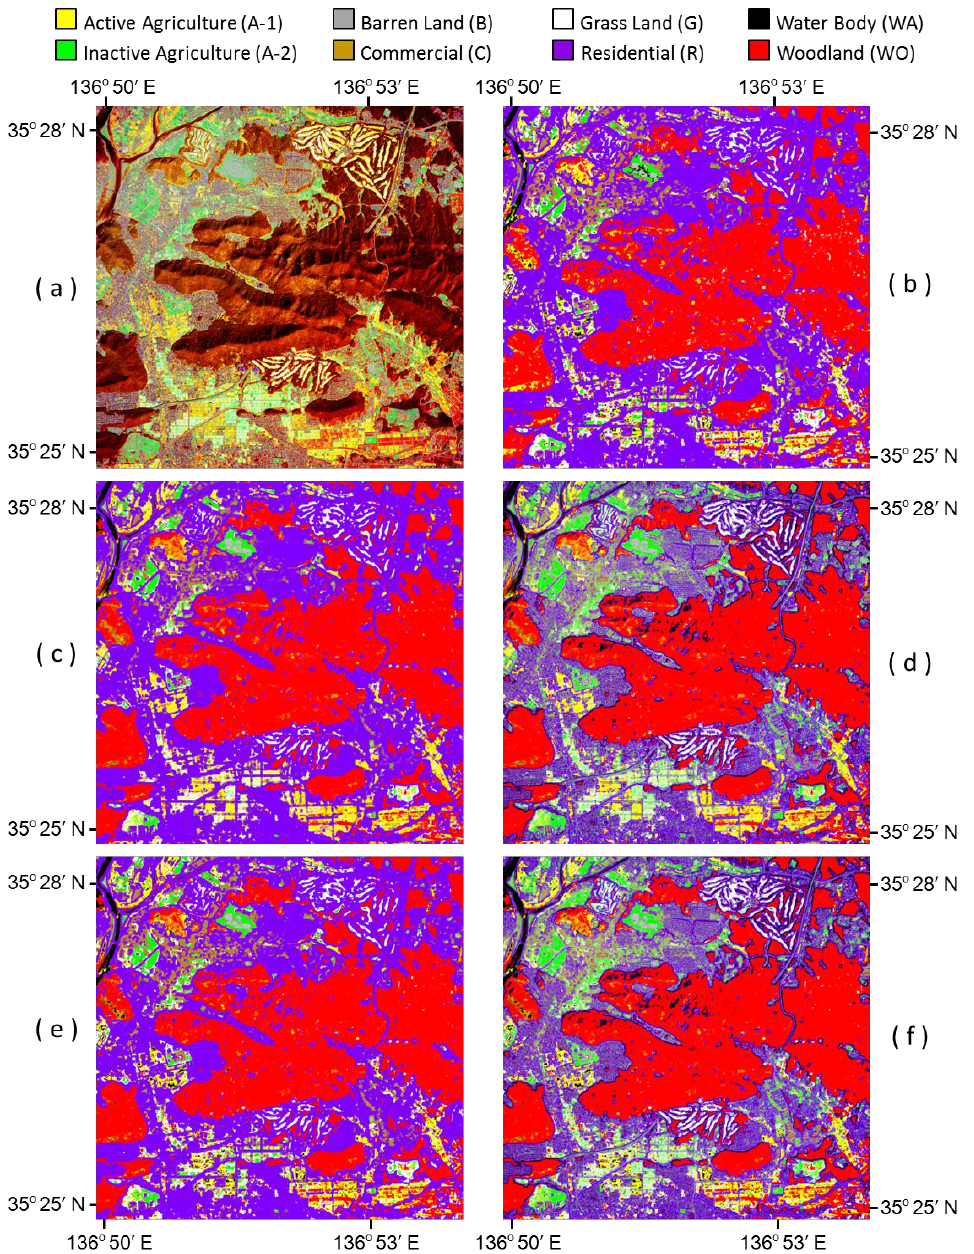
Figure 6. Output maps: ( a ) S; traditional spectral approach, ( b ) L; Lacunarity gray-scale approach, ( c ) SL; combination of spectral approach and lacunarity technique, ( d ) G1; gradable method using the results of the SL and S, ( e ) G2; gradable method using the results of SL and L, ( f ) G3; gradable method using the results of SL, S and L. (Note: The same class colors are